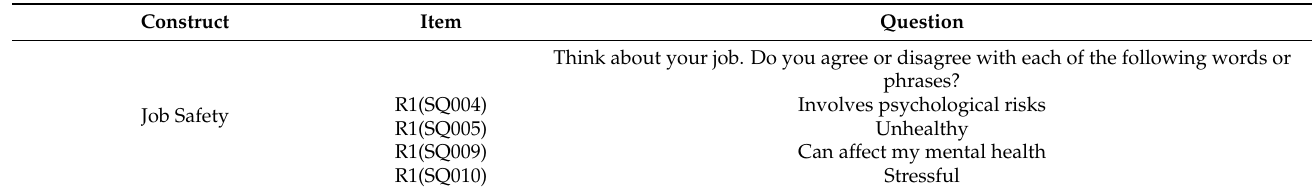
Table A1. Research